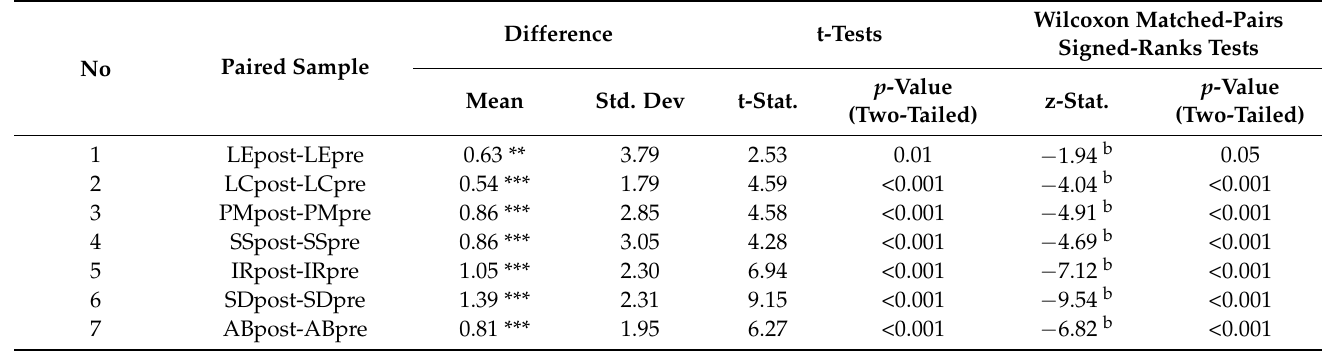
Table 3. The tests of the differences between the paired samples in mean (N = 231).